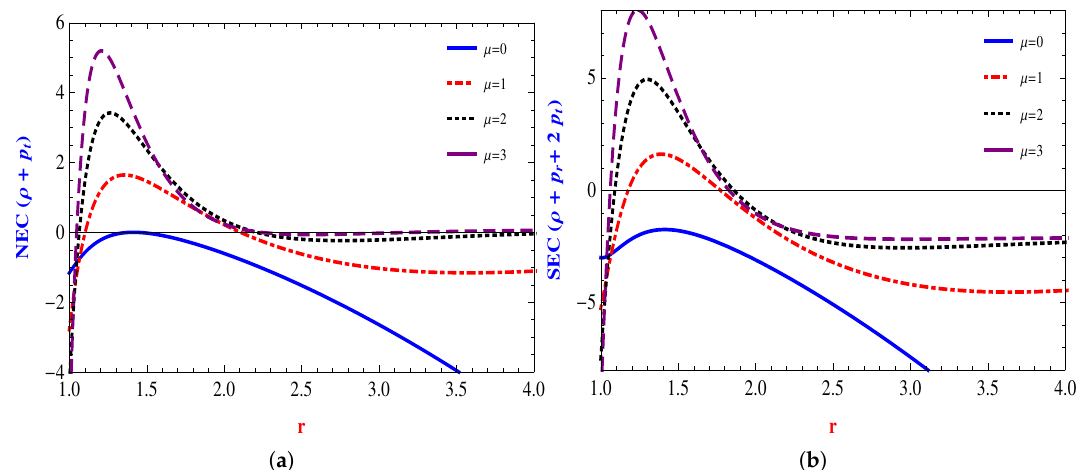
Figure 8. Plots: ( a ) Tangential NEC ( ρ + p t ) and ( b ) SEC ( ρ + p r + 2 p t ) with throat radius r 0 = 1, α = 1, β = 1, and γ = 2 in f ( Q ) = α Q 2 + β Q + γ gravity.